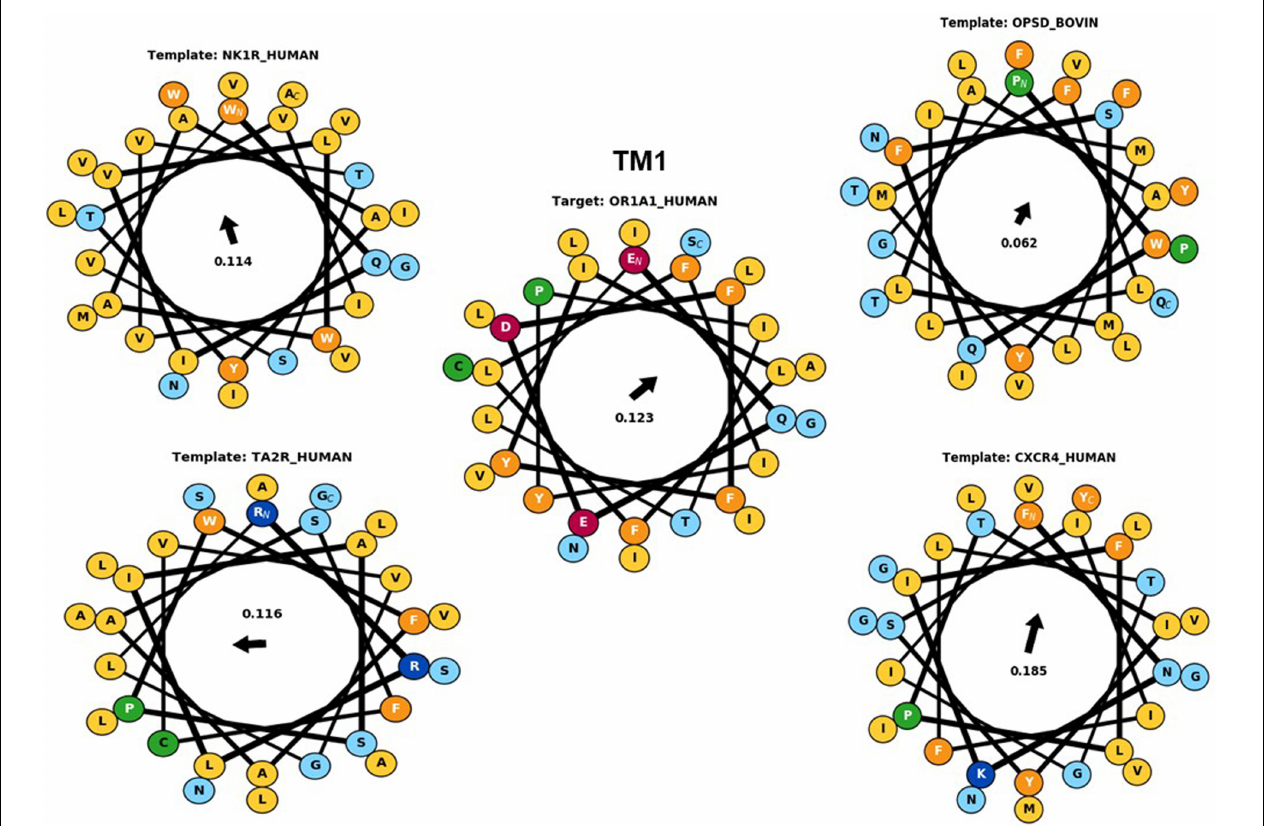
FIGURE 4 | The helical wheel plots are taken from Bio-GATS for the TM1 of the target sequence (OR1A1) and the templates [NK1R_Human (6HLP), OPSD_BOVIN (1U19), TA2R_Human (6IIU), and CXCR4_Human (3ODU)]. The hydrophobic moment for OR1A1 and 1U19 are pointing in similar directions.